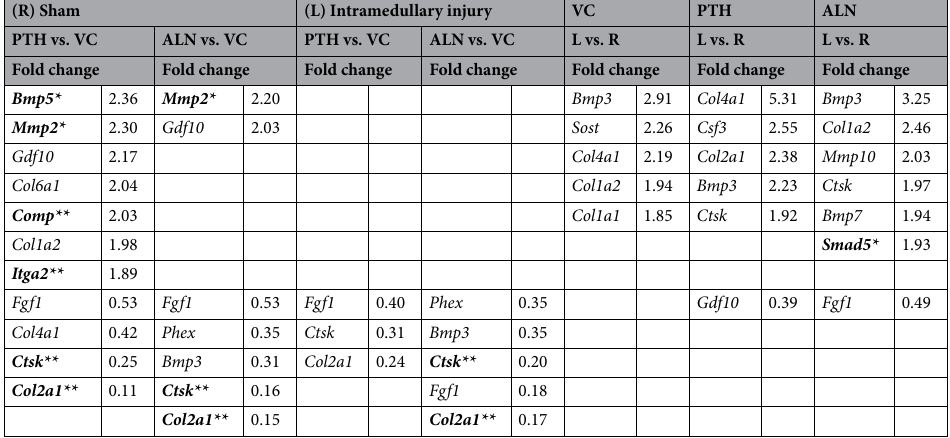
Table 1. Summary of up- or down-regulated osteogenic genes in the diaphyseal bone marrow. Upregulated genes with a fold change of 1.5 and above and downregulated genes with a fold change of 0.5 and below are shown. Statistical difference between groups, *: p < 0.05, **: p <